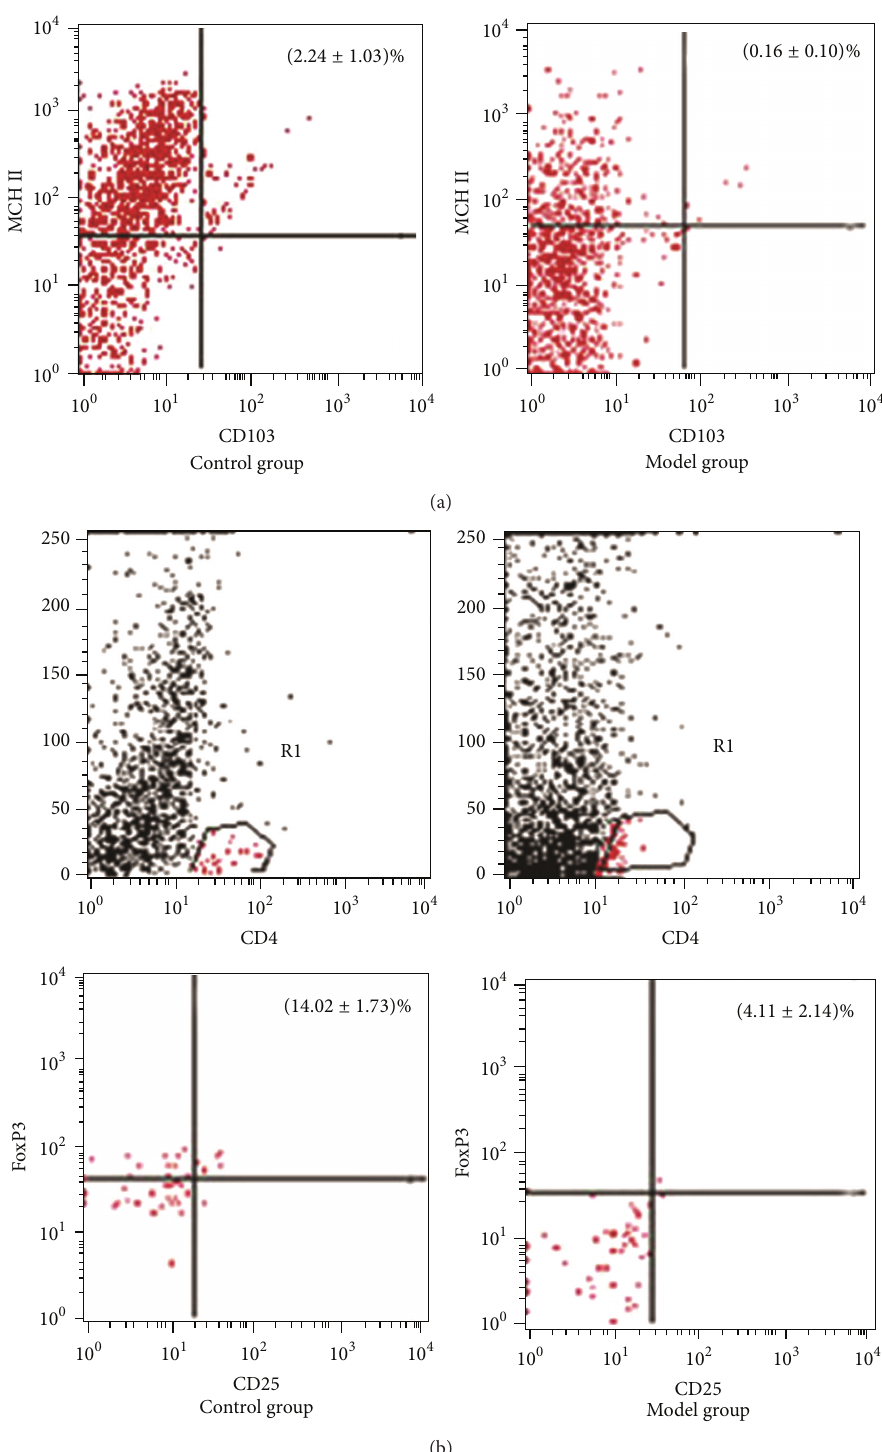
Figure 2: The percentage of CD103 + MHCII + DCs and CD4 + CD25 + FoxP3 + T-regs in the control and model group. (a) In the model group, the percentage of CD103 + MHCII + DCs in the total colonic mucosal cells was significantly lower than that in the control group ( 0.16 ± 0.10 versus 2.24±1.03 , 𝑃 < 0.05 ). (b) Compared with control group, the percentage of CD4 + CD25 + FoxP3 + T-regs in CD4 + T cells was significantly lower in the model group ( 4.11 ± 2.14 versus 14.02 ± 1.73 , 𝑃 < 0.05